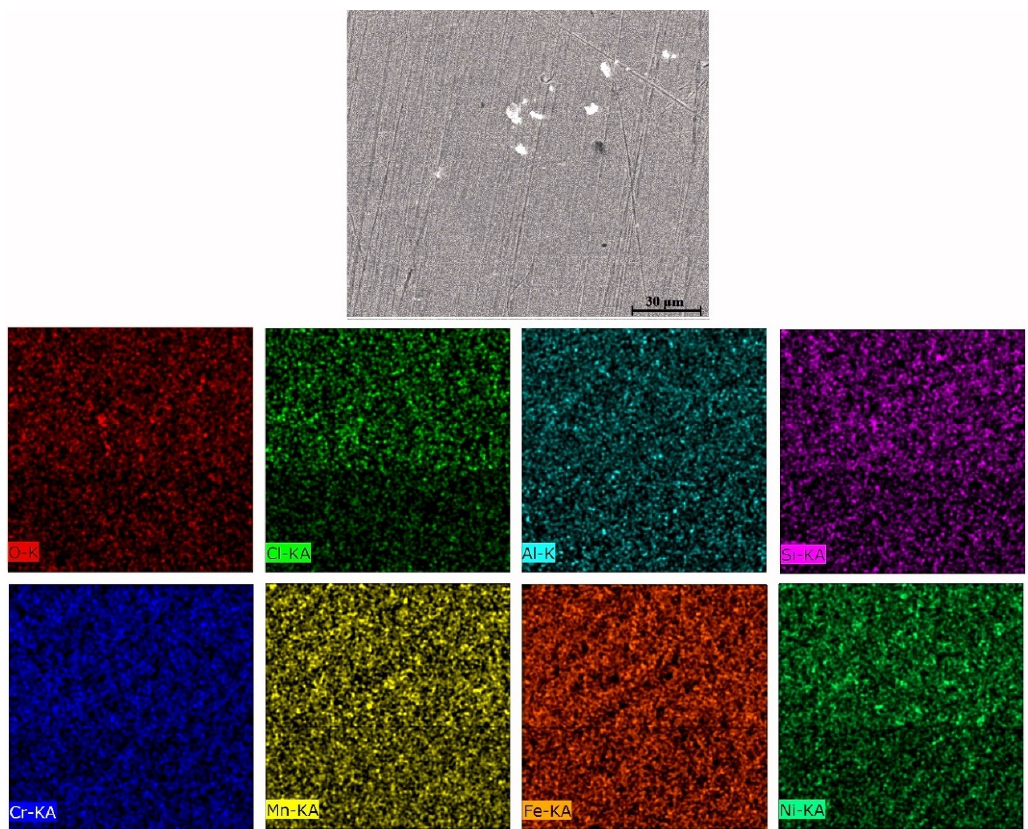
Figure 10. EDX elemental mapping of the corroded cold-rolled Fe 36 Mn 20 Ni 20 Cr 16 Al 5 Si 3 HEA in 0.6 M NaCl.